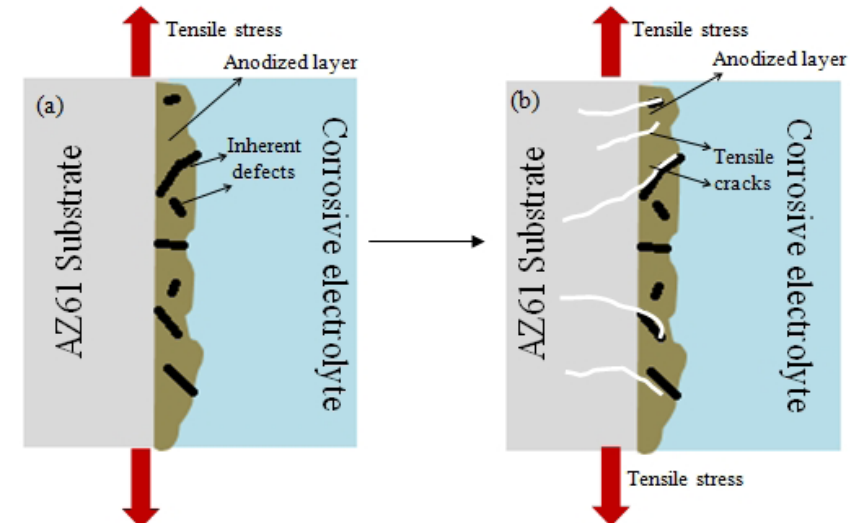
Figure 16. Schematic illustration of the SCC behavior of the anodized AZ61 in 0.1 M NaCl solution: a) Anodized AZ61 alloy immersed in the corrosive electrolyte and subjected to tensile stress. The anodized layer is permeated by inherent defects formed during the electrolytic oxidation process; b) Inherent defects of the anodized layer act as stress risers, being the preferential sites for crack nucleation and